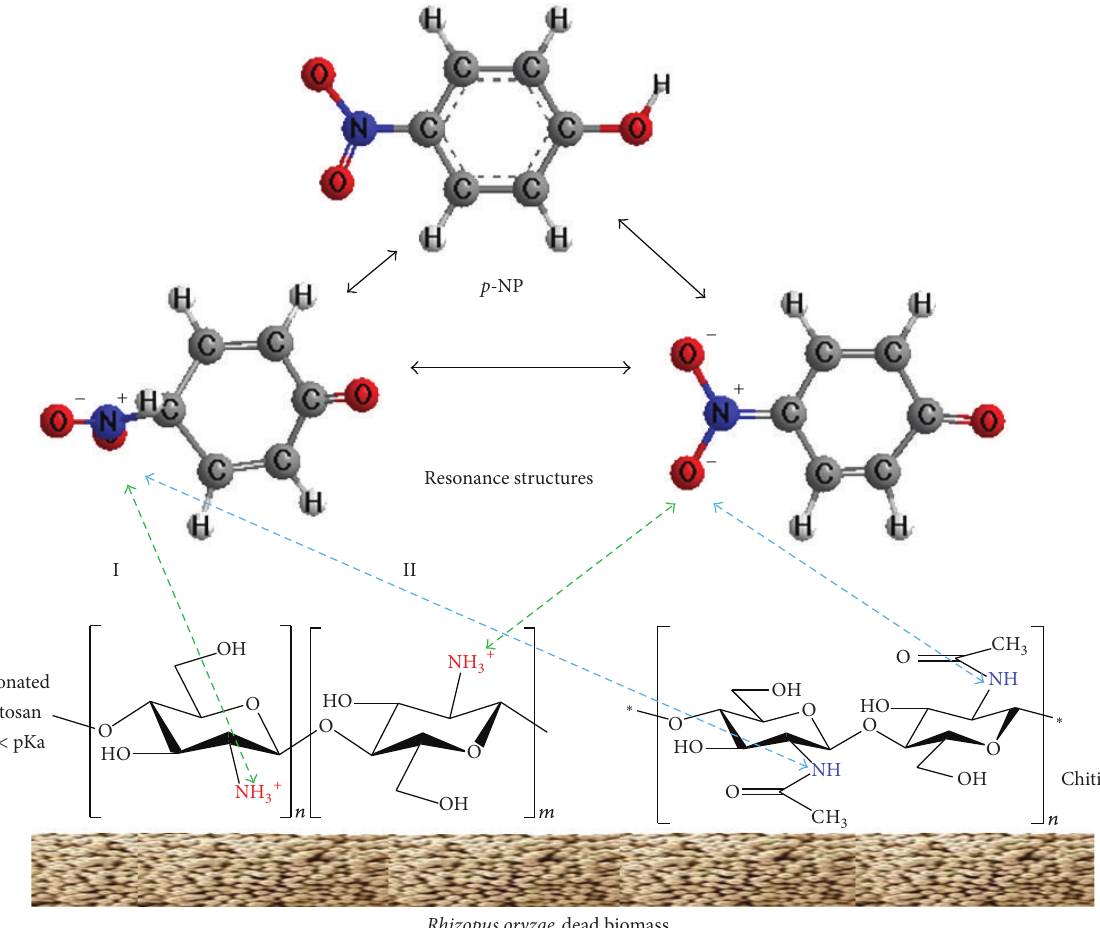
F 3: e proposed mechanism of p -NP biosorption by R. oryzae dead biomass. Note . I: chemical interactions between protonated chitosan groups and p -NP functional groups; II: chemical interactions between amine nitrogens of chitin.